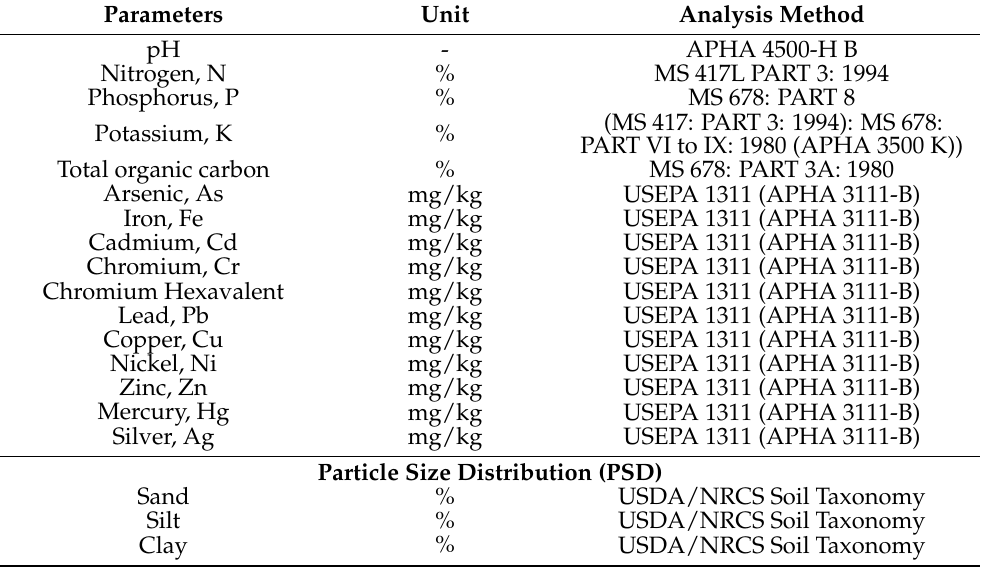
Figure 6. Random sampling method at 5 different points in a designated area [53]. Table 5. Selected parameters and analytical